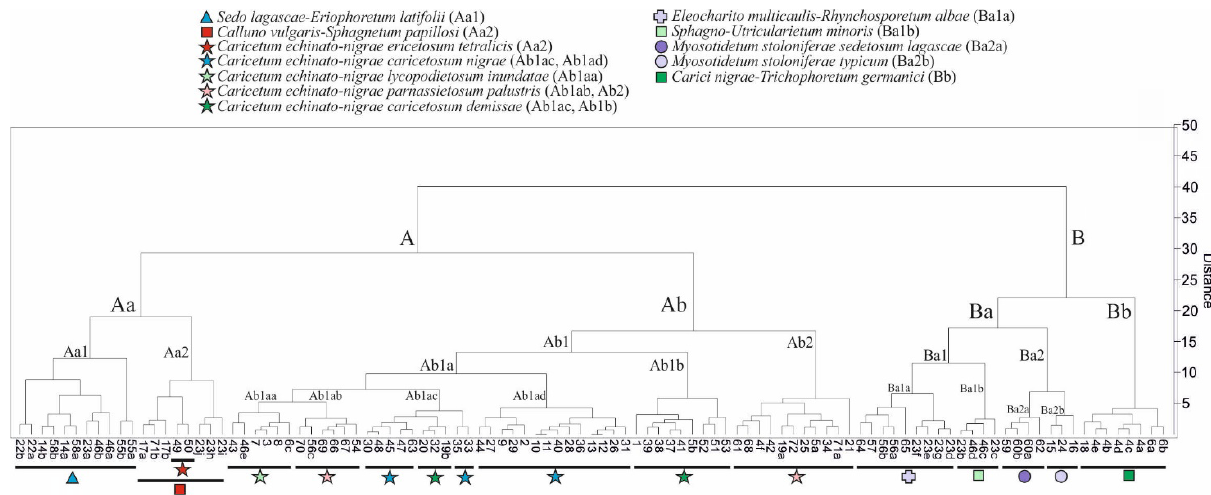
Figure 4. Dendrogram resulting from cluster analysis of the